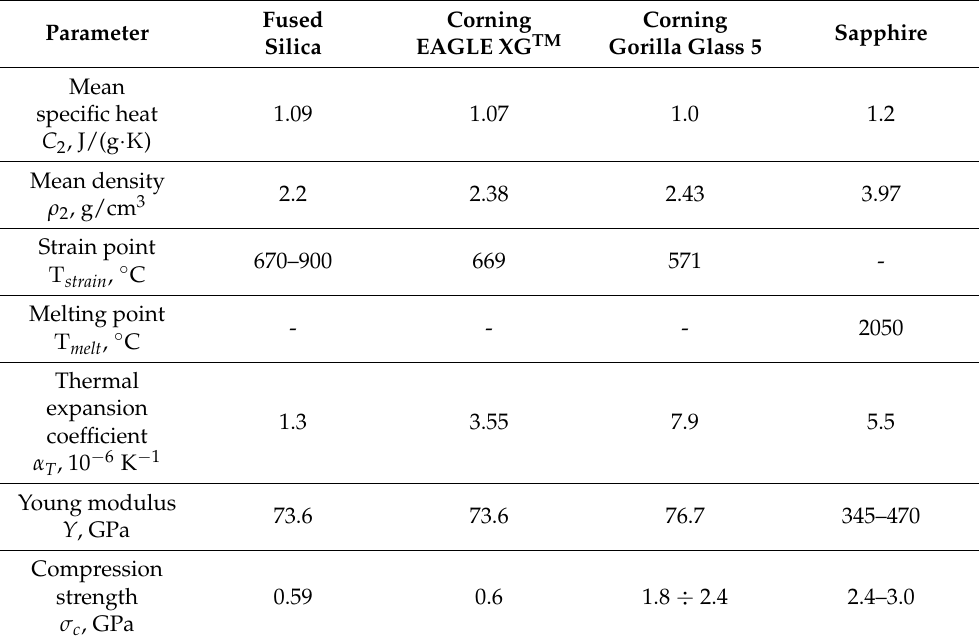
Table 2. Parameters of amorphous and crystalline materials [55–57] used in the modelling. Fused Corning Parameter Silica EAGLE XG TM